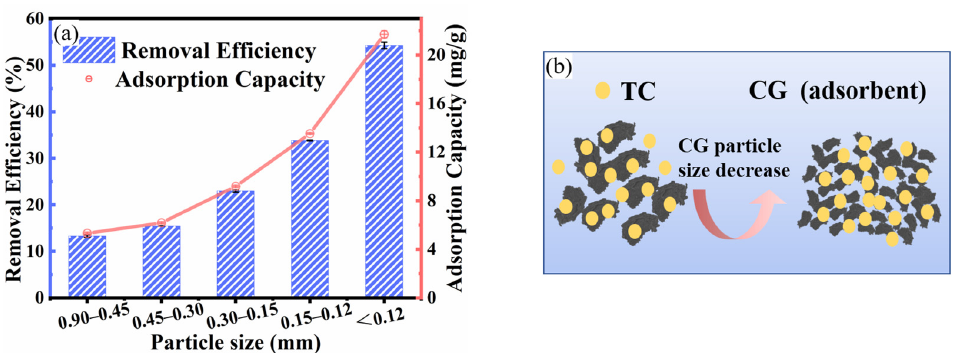
Figure 4 . Effect of adsorbent dosage for TC adsorption: ( a ) Effect of CG dosage on removal efficiency and adsorption capacity of TC by CG (contact time of 3 h, TC concentration of 40 mg/L, pH of 6.2 and temperature of 25 °C, 120 rpm); ( b ) the proposed schematic diagram of TC adsorption by CG with increasing CG dosage.